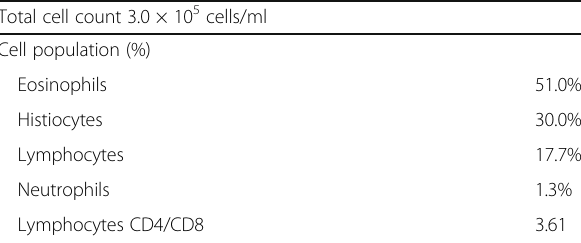
Table 1 BALF data. Results of the BALF cell